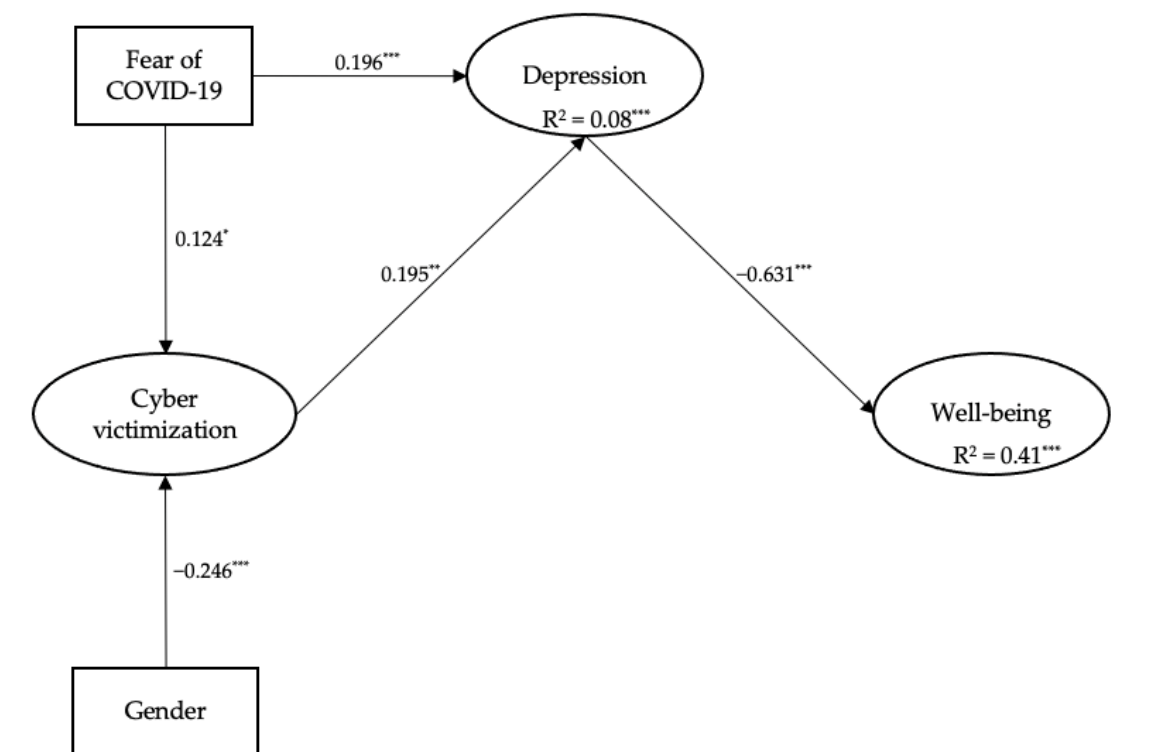
Figure 1. The standardised path coefficients of the mediational model. For clarity, only the significant